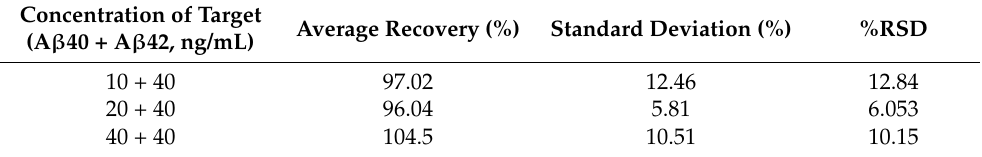
Figure 5. Spiking and recovery in protein mixtures. A specific concentration of A β 42 was spiked, and the average recovery signals were estimated. One-way ANOVA followed by Dunnett’s multiple comparisons tests were performed for statistical analysis (** p ≤ 0.01, **** p ≤ 0.0001). All tests were performed in triplicate under the same conditions. Table 3. Spiking and recovery rate.